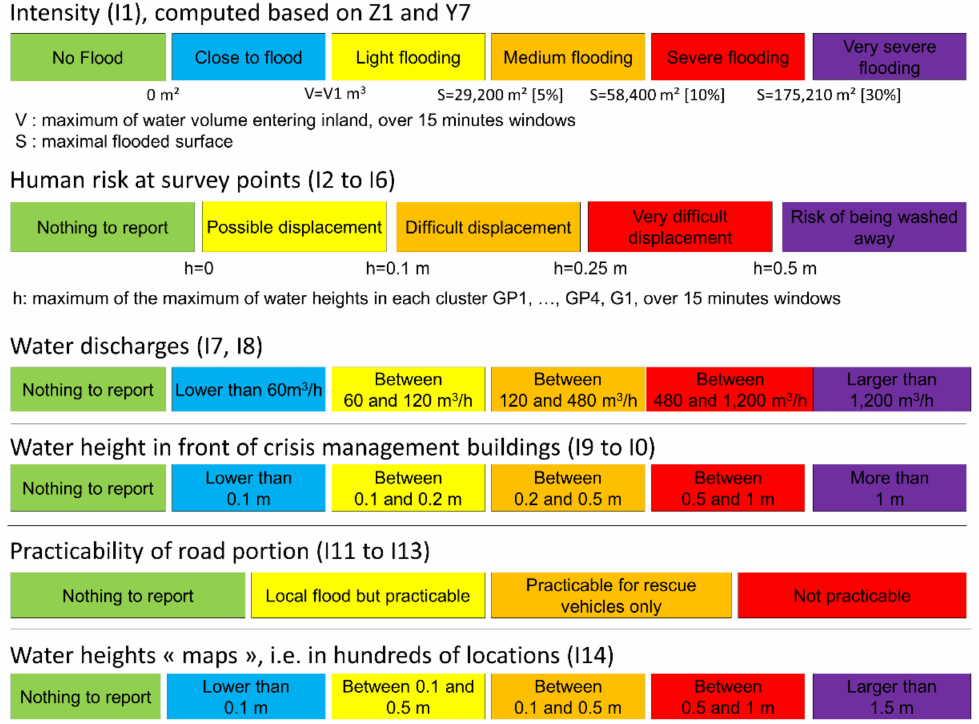
Figure 3. Colour scale for each indicator I j . For each indicator, the number of classes differs, ranging from 1 to 4, 1 to 5, or 1 to 6, depending on the